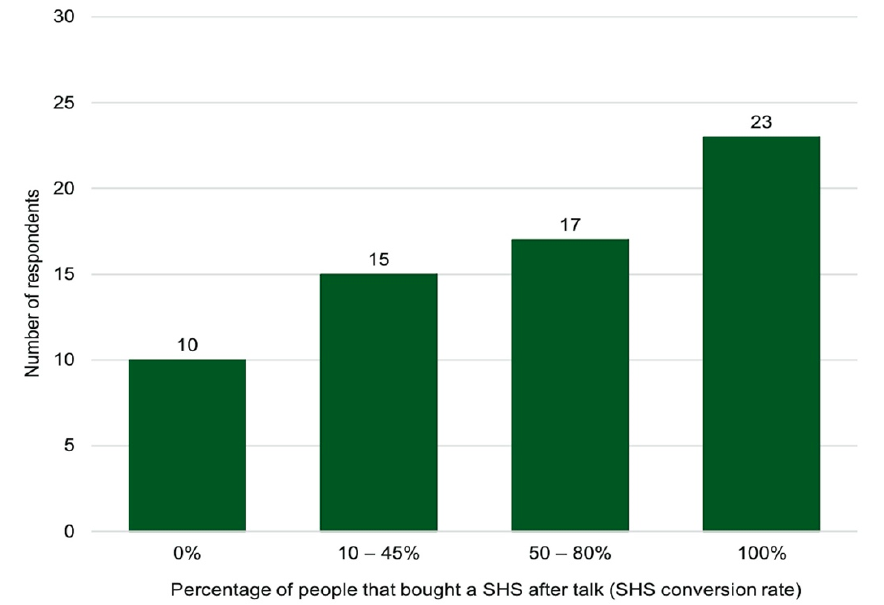
Figure 8. Number of respondents per SHS conversion rate.